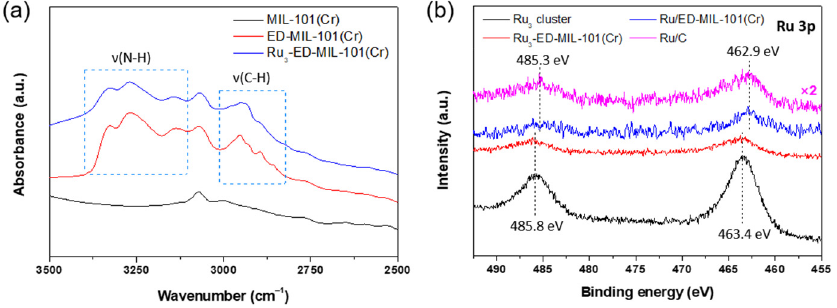
Figure 3. ( a ) In situ FTIR spectra of MIL-101(Cr) (black), ED-MIL-101(Cr) (red), and Ru 3 -ED-MIL- 101(Cr) (blue) measured at 150 °C. ( b ) Ru 3p XPS spectra of Ru 3 clusters (black), Ru 3 -ED-MIL-101(Cr) (red), Ru/ED-MIL-101(Cr) (blue), and Ru/C (pink).